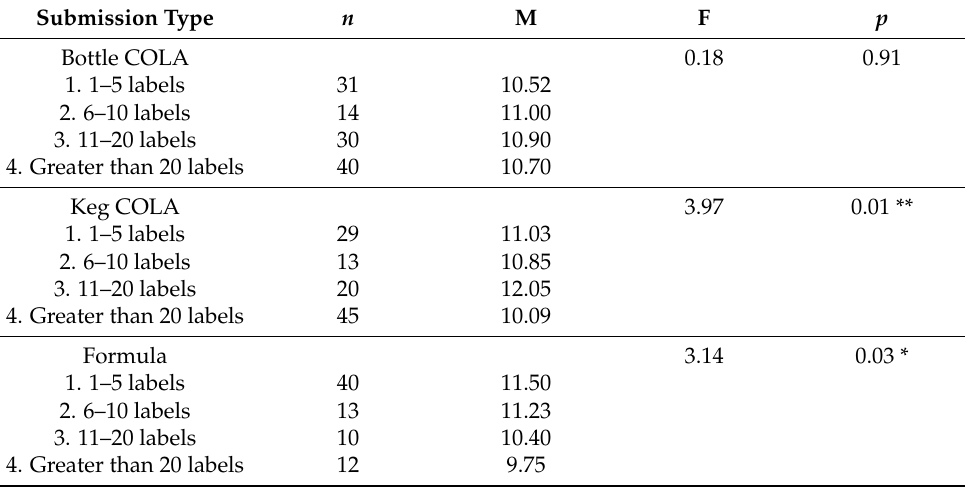
Table 15. ANOVA Results: Perception Scores among Submission Volume Categories.